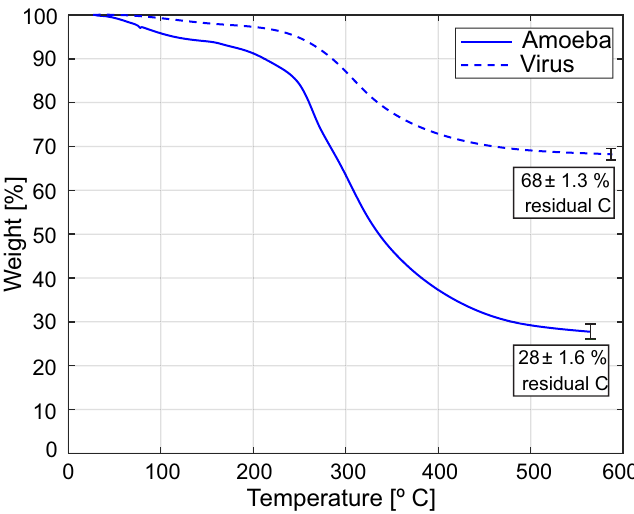
Figure 4. TGA thermograms of virus and cells. Solid line represents cells and dashed line represents virus. Measurements (n = 2) were performed under inert atmosphere. The residual mass after pyrolysis consists mostly of char, and was used to estimate the relative carbon content of virus (68%) and amoeba (28%). The error bars represent the standard error of the